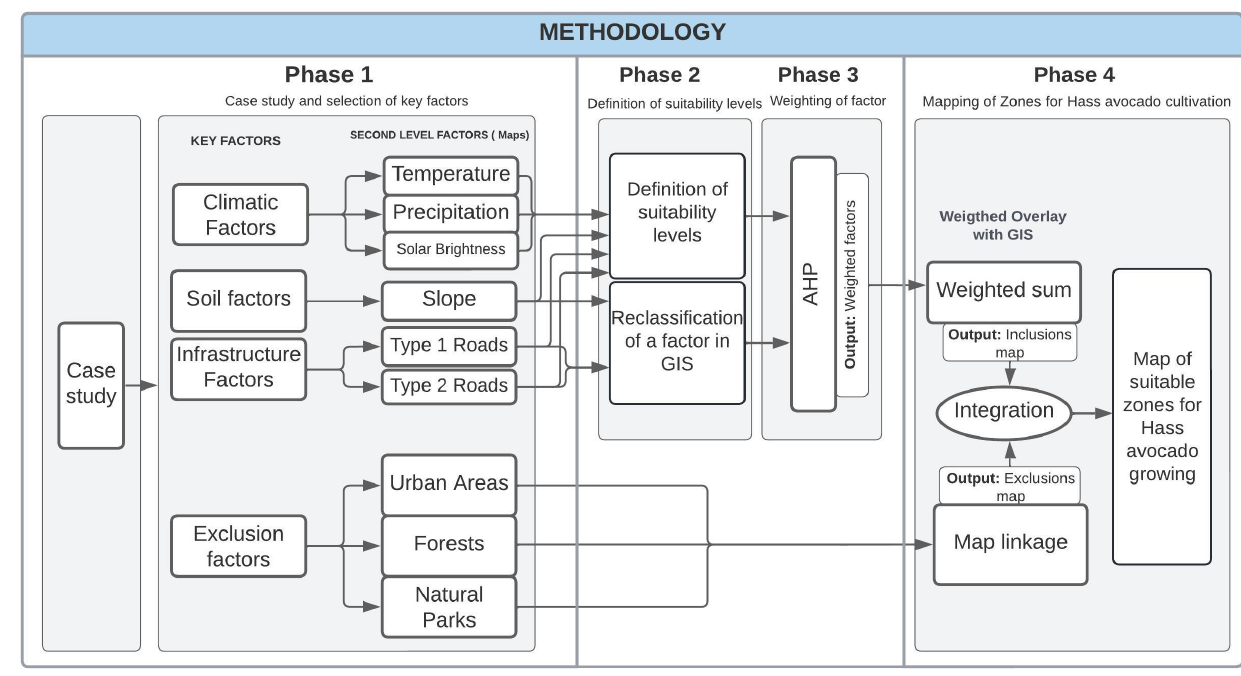
Figure 1. A methodological process was followed to obtain the suitability maps for Hass avocado cultivation in the Cauca department, Colombia, in